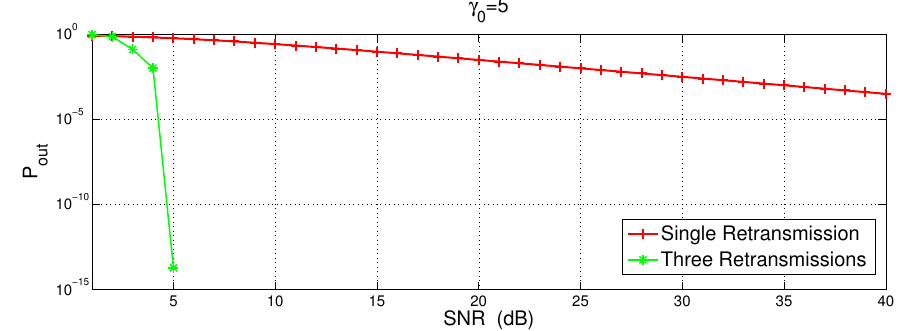
Figure 3. P out of incremental relaying with cooperative